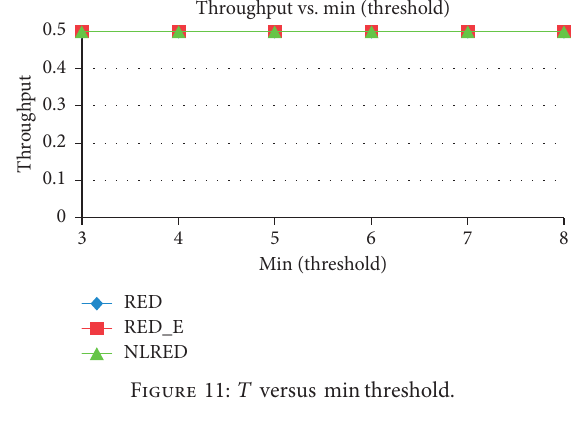
Figure 11: T versus minthreshold.